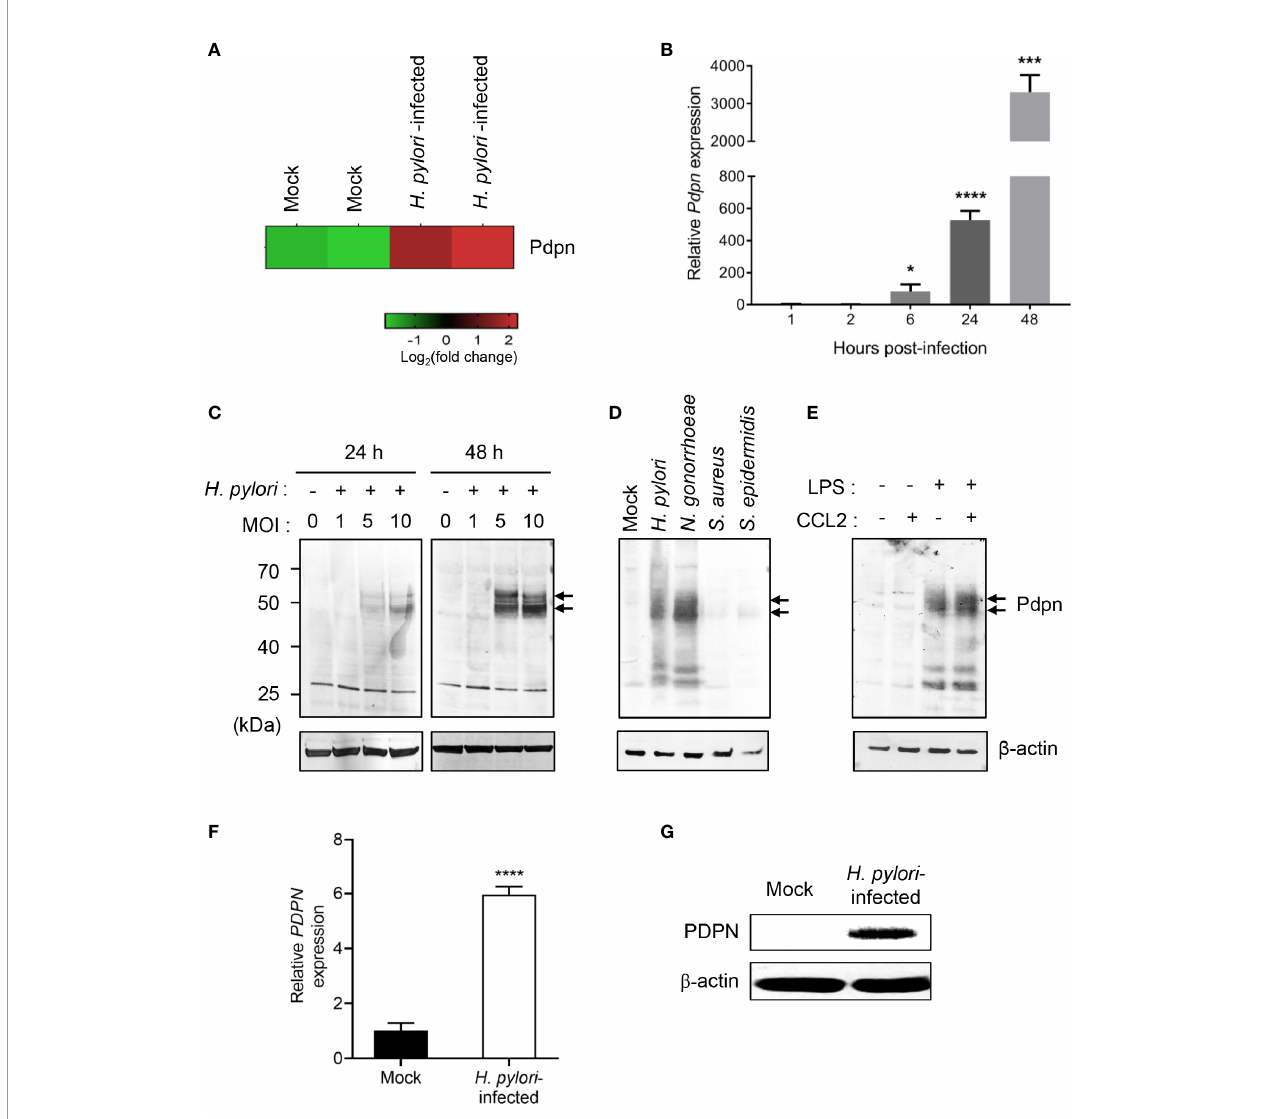
FIGURE 1 | Upregulation of Pdpn expression in H. pylori -infected macrophages. (A) Microarray heatmap shows Pdpn gene expression in uninfected (mock) or H. pylori (MOI 10, 24 h)-infected RAW264.7 cells. Data were ran with two biological duplicates and were representative of two different probes. (B) Temporal Pdpn mRNA transcript expression of mock or H. pylori (MOI 10)-infected RAW264.7 cells. y- axis shows relative expression of Pdpn to b - actin internal control. Data were shown as mean ± SD , from two experiments ran in triplicate. Statistical signi fi cance was analyzed with unpaired Student ’ s t -test (* p < 0.05, ***p < 0.001, **** p < 0.0001) in comparison to level of uninfected control. (C – E) Immunoblot analyses show Pdpn protein expression in RAW264.7 cells under different stimulation conditions. Pdpn expressions were examined in (C) mock or H. pylori (MOI 1, 5, or 10)-infected cells at 24 or 48 h.p.i.; (D) mock, H. pylori , N. gonorrhoeae , S. aureus , and S. epidermidis (MOI 10, 24 h)-infected cells; and (E) LPS (1 ng/ml)-, CCL2 (100 ng/ml)-, or LPS plus CCL2-stimulated cells. Membranes were probed using anti-Pdpn (upper panel, as indicated by arrows) or anti- b -actin (lower panel) antibodies. Ladder indicates molecular weight, kDa: kiloDalton. Data were representative of at least two independent experiments. (F, G) THP-1 cells were uninfected (mock) or infected with H. pylori J99 strain at MOI 10 for 16 h. (F) PDPN mRNA transcript expression was examined by qRT-PCR method. y- axis shows relative expression of PDPN to b - actin internal control. Data are shown as mean ± SD , from two experiments run in triplicate. Student ’ s t -test was used for statistical analysis; **** p < 0.0001. (G) Immunoblot analysis shows PDPN protein expression in THP-1 cells in mock or H. pylori (MOI 10 for 16 h)-infected cells. Membranes were probed using anti-PDPN or anti- b -actin antibodies. Data were representative of at least two independent